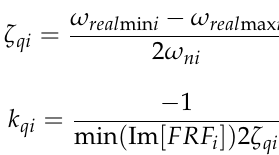
Figure 5 illustrates the procedure for optimization of dynamic cutting force coeffi ‐ cients for the end ‐ milling process based on the EO algorithm. The first step was to